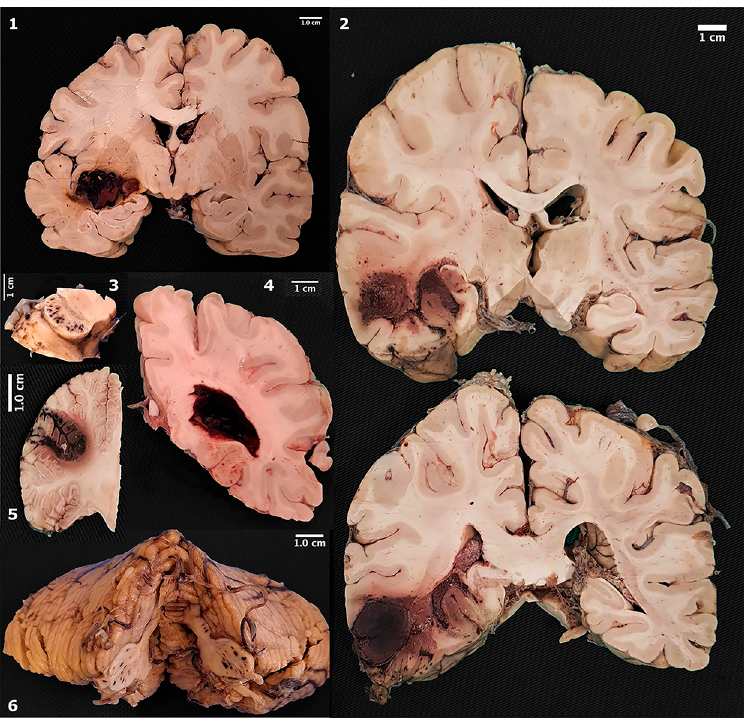
Fig 1. Gross pathology of macroscopic hemorrhages. 1. Hemorrhage in the putamen; 2. Extensive hemorrhage in temporal lobe; 3. Punctate hemorrhages in cerebral peduncles; 4. Lateral ventricle filled by blood; 5. Focal hemorrhage in cerebellar cortex; 6. Punctate hemorrhages in middle cerebellar